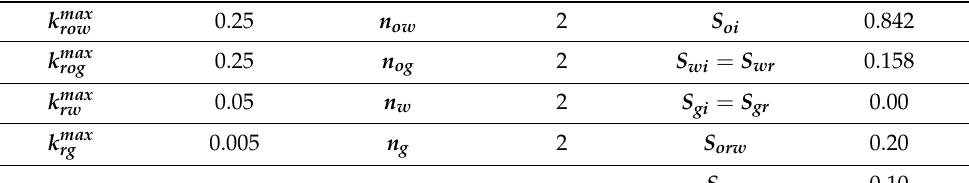
Table A2. Reservoir flow properties in terms of relative permeability end points, Corey exponents, initial and residual saturations.